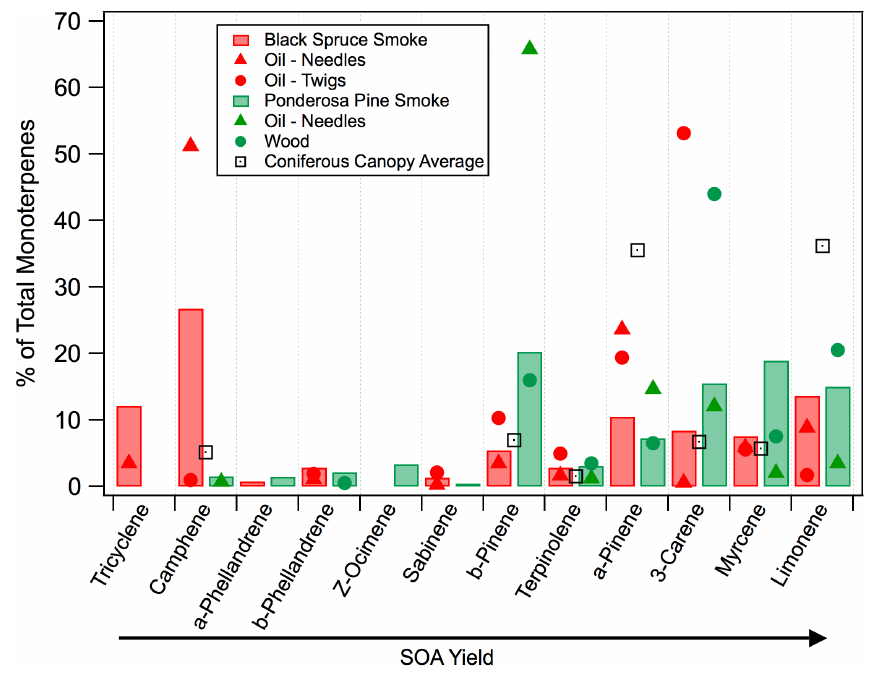
Figure 10. Distribution of the monoterpene isomers observed in smoke from fires of black spruce (BS) and ponderosa pine (PP), as a percentage of the total monoterpene EF. The compounds are sorted in order of increasing SOA yield, largely based on Lee et al. (2006). Colored markers represent the percentage of each monoterpene measured in the essential oils of BS needles and twigs (von Rudloff, 1975) and PP needles (Krauze-Baranowska et al., 2002) and wood (Anderson et al., 1969). Black squares indicate the MT emissions averaged over coniferous canopy fires reported in Yokelson et al. (2013). All literature values were converted to % of reported